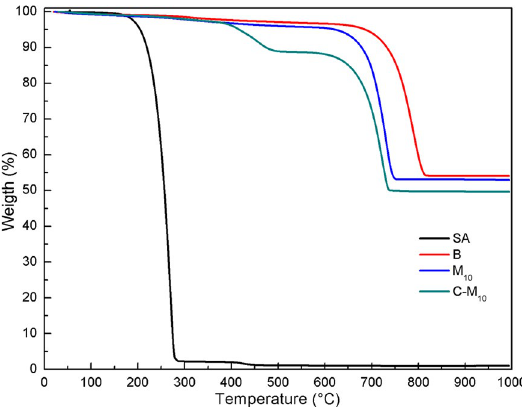
Figure 2. TGA thermogram of stearic acid (SA), eggshell (B), ball milled (M ) and ball milled SA(C-M 10